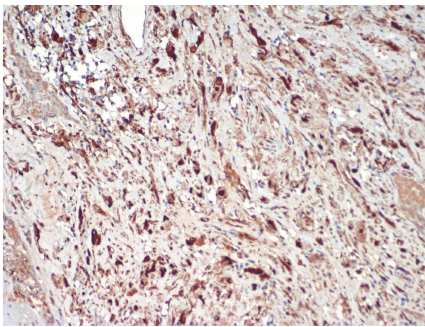
Figure 5: Photomicrograph showing diffuse immunohistochemical positivity for S-100 (HRP